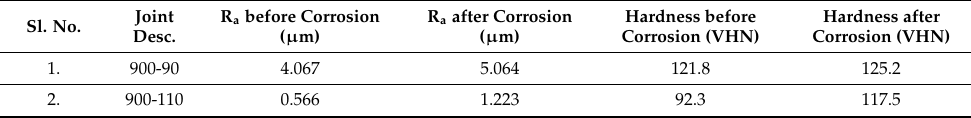
Table 8. Surface roughness and Hardness before and after